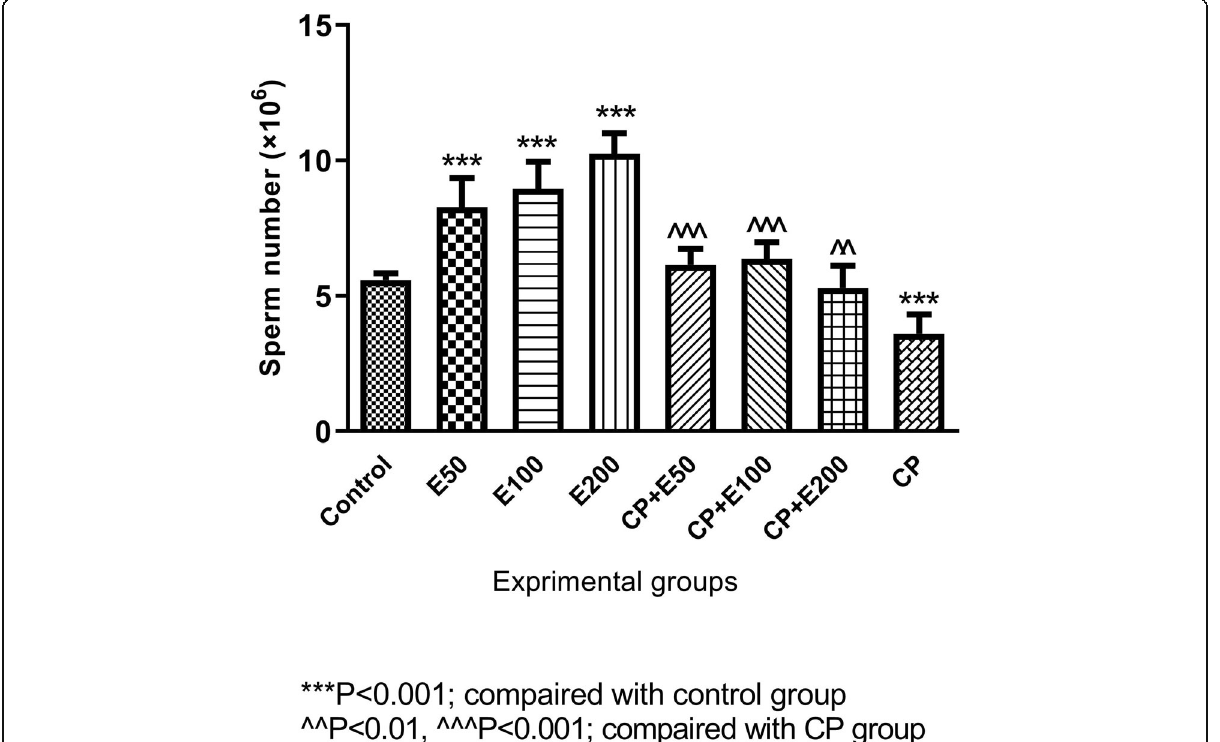
Fig. 1 The effect of Allium atroviolaceum L. extract (E) on sperm count in cyclophosphamide (CP)-treated